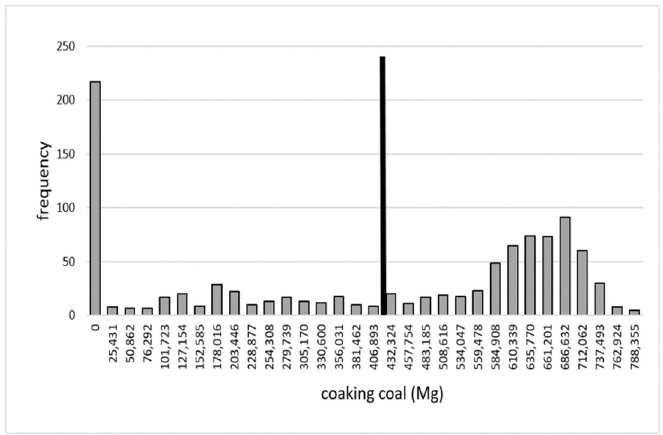
Figure A13. Histogram showing frequencies of achieving given quantity of sales of coking coal (“Cokerys 1”) for mine “D” with σ yprog .